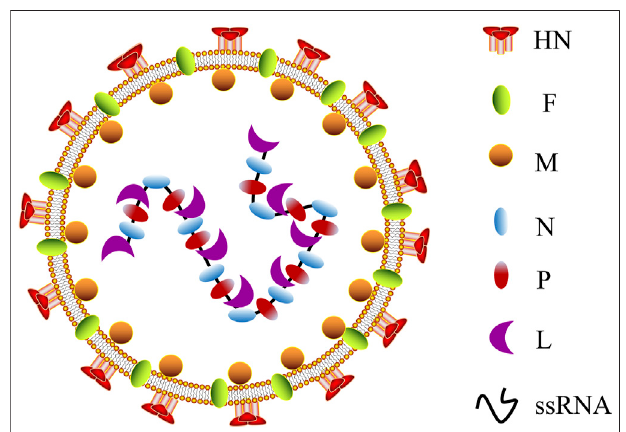
FIGURE 1 | Schematic representation of NDV morphology. NDV, Newcastlediseasevirus;HN,hemagglutinin – neuraminidase;F,fusionprotein; M, matrix protein; N, nucleocapsid protein; P, phosphoprotein; L, RNA- dependent large polymerase protein; ssRNA, single-stranded